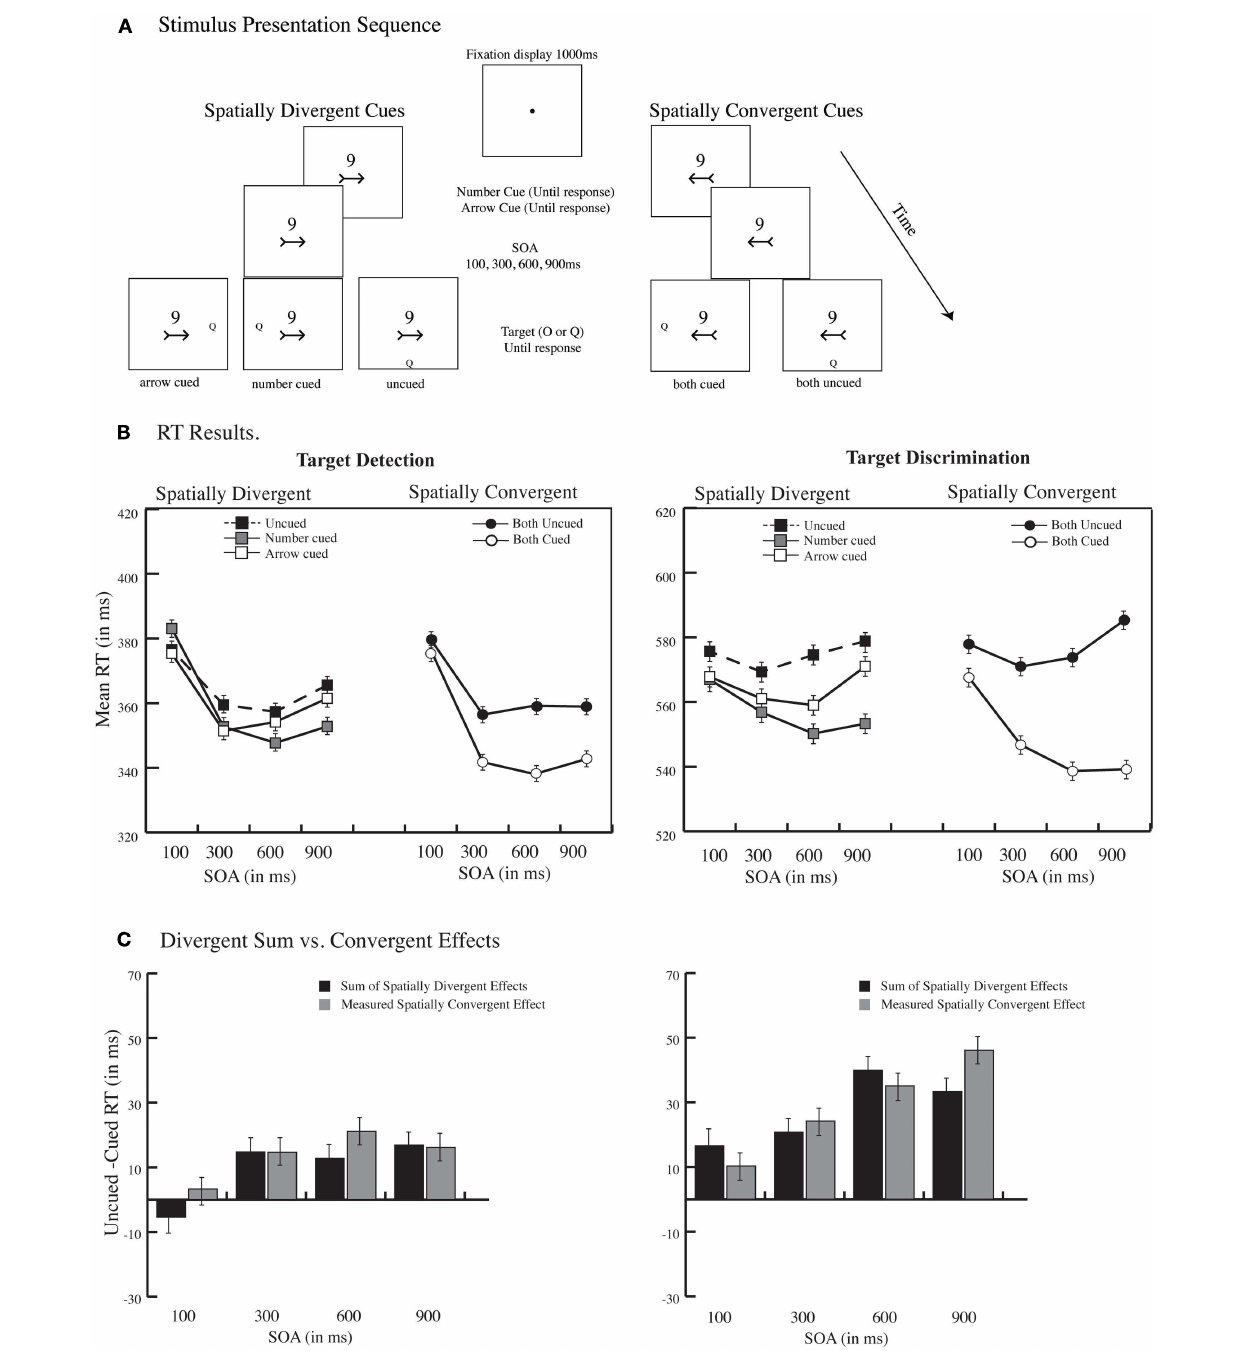
(O or Q), demanding either a detection or a discrimination response, appeared in one of the possible four locations, and remained on the screen until a response. Note that stimuli are not drawn to scale. (B) RT Results. Mean correct RT is plotted as a function of cue spatial position (divergent vs. convergent), cue validity, and SOA for target detection and target discrimination. (C) Divergent sum vs. Convergent Effects.The magnitude of orienting (uncued – cued RT) plotted as a function of SOA when the two cues indicated the same spatial location (convergent cues) and the sum of orienting effects when the two cues indicated different spatial location (divergent cues). Error bars depict the standard error of the difference between the